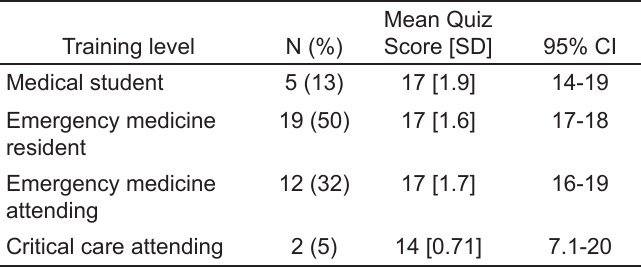
Table 1. Participant specialty and training levels.